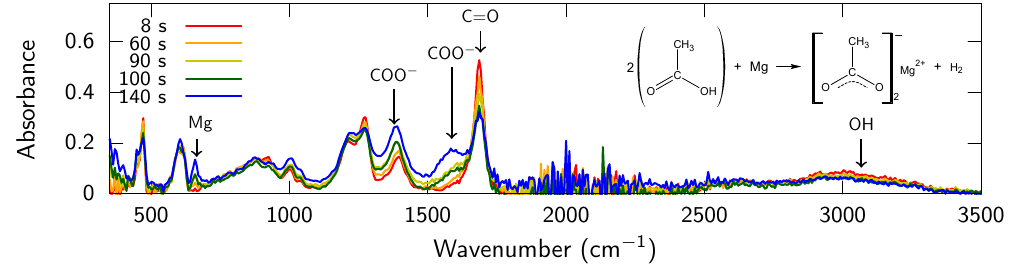
Figure 1. Snapshots of the MIR absorption spectrum of acetic acid during the chemical reaction with metallic magnesium.